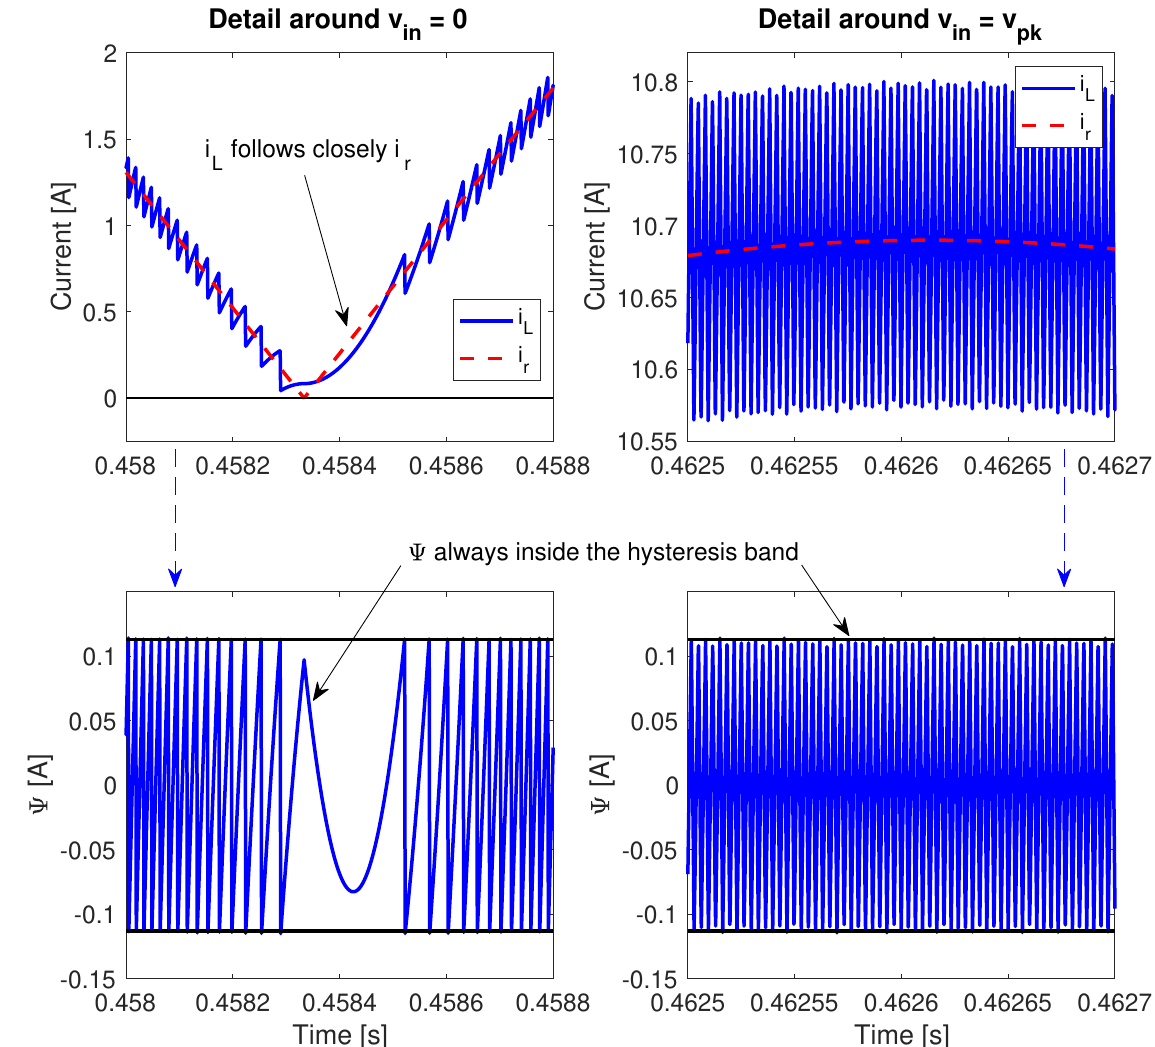
Figure 15. Zoom at v in around 0 V ( left ) and v in around v pk ( right